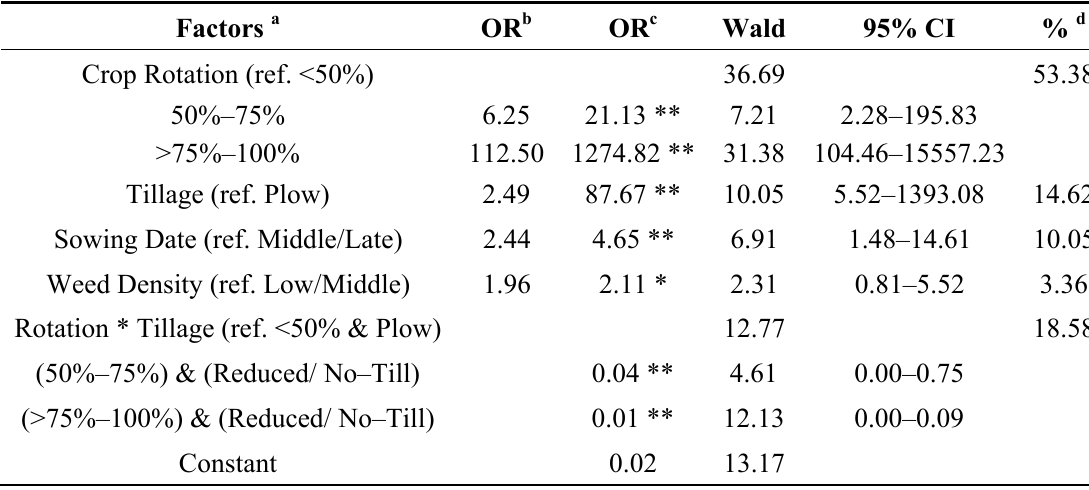
Table 3. Predictor variables of herbicide resistance for the LRM. Probability of resistance selection with respect to the reference category is shown for each statistically significant factor and is given by the crude (univariate model) and adjusted odds ratio (multivariate model with all factors considered as independent variables in the regression). The significance of the predictor variables is shown by Wald statistic and 95% confidence interval (CI) of the adjusted OR in the multivariate model. Percentage distribution of the factors influencing herbicide resistance is given in terms of relative contribution of the predictor